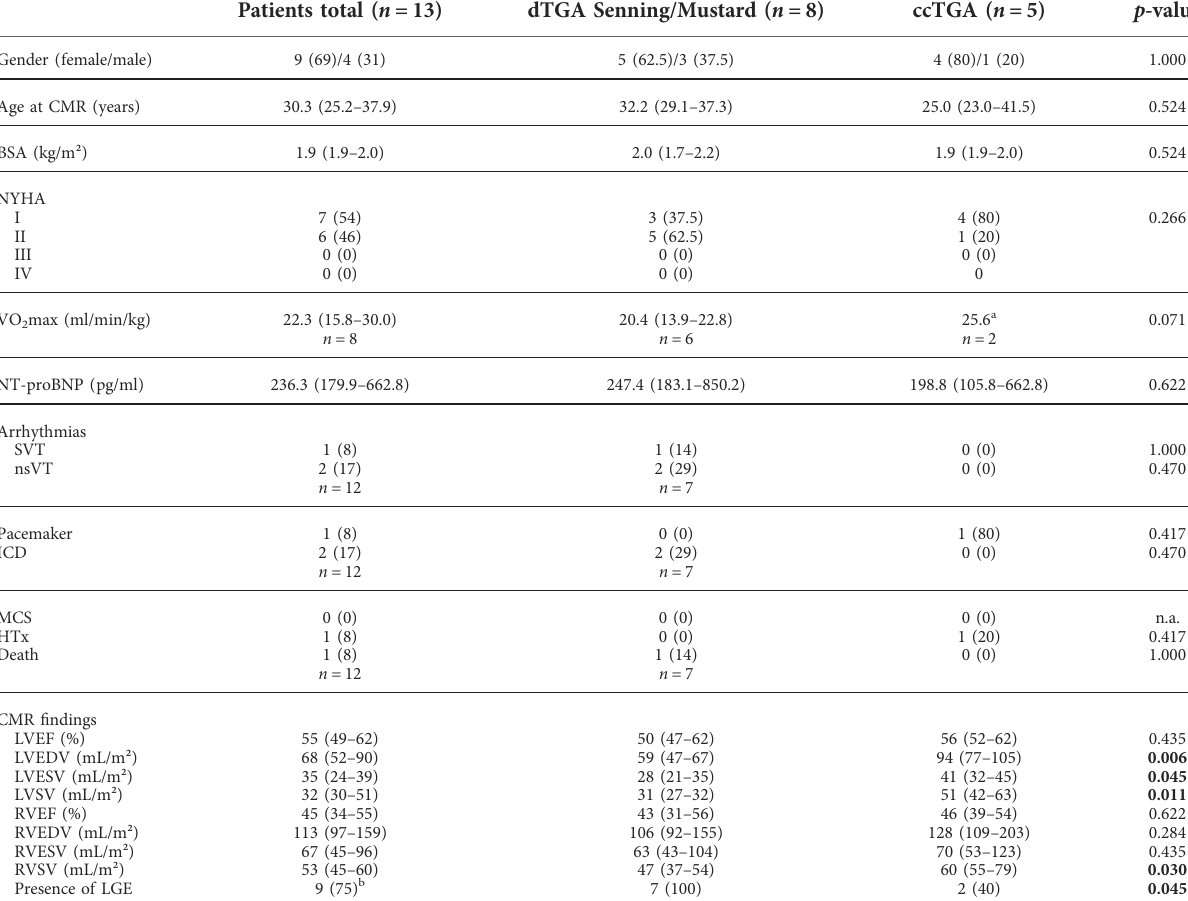
TABLE 1 Patient